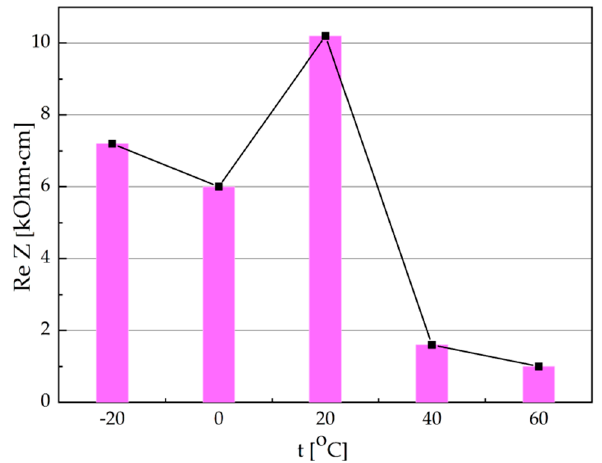
Figure 16. Temperature dependence of the real part of the complex impedance for GaSe ( SC(NH 2 ) 2 ( SmCl 3 )), measured perpendicularly to the layers.